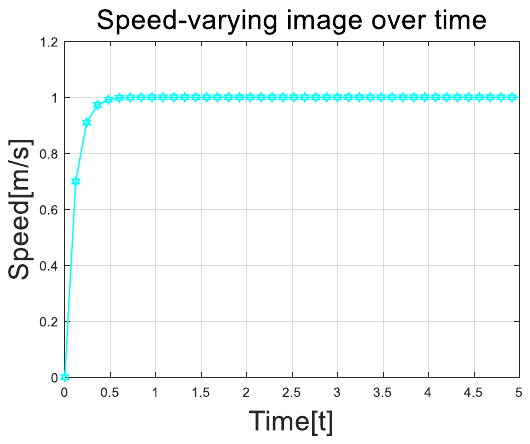
Figure 4. Speed change versus time.